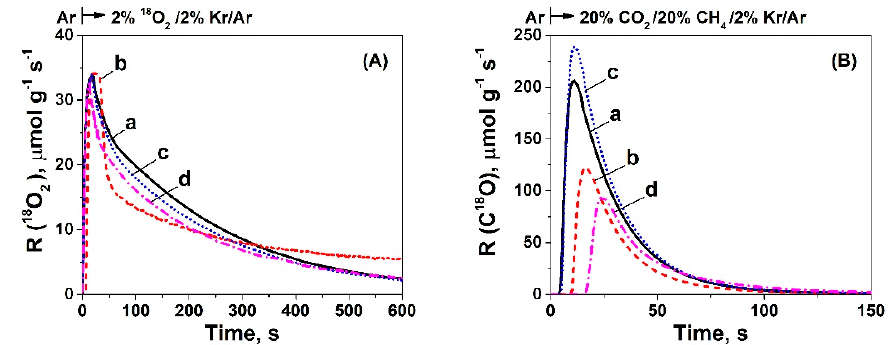
Figure 8. Transient rates ( μ mol g − 1 s − 1 ) of ( A ) 18 O 2 consumption during 16 O/ 18 O exchange at 750 °C after the gas switch: Ar → 2% 18 O 2 / 2% Kr / Ar, ( B ) C 18 O formation obtained during the switch from Ar → 20% CH 4 /20% CO 2 /2% Kr/Ar/He (t) over 5 wt% Ni/CeO 2 prepared by (a) Thermal decomposition (TD), (b) Precipitation (PT), (c) Hydrothermal (HT), and (d) Sol-Gel (SG) method. W cat = 0.02 g.